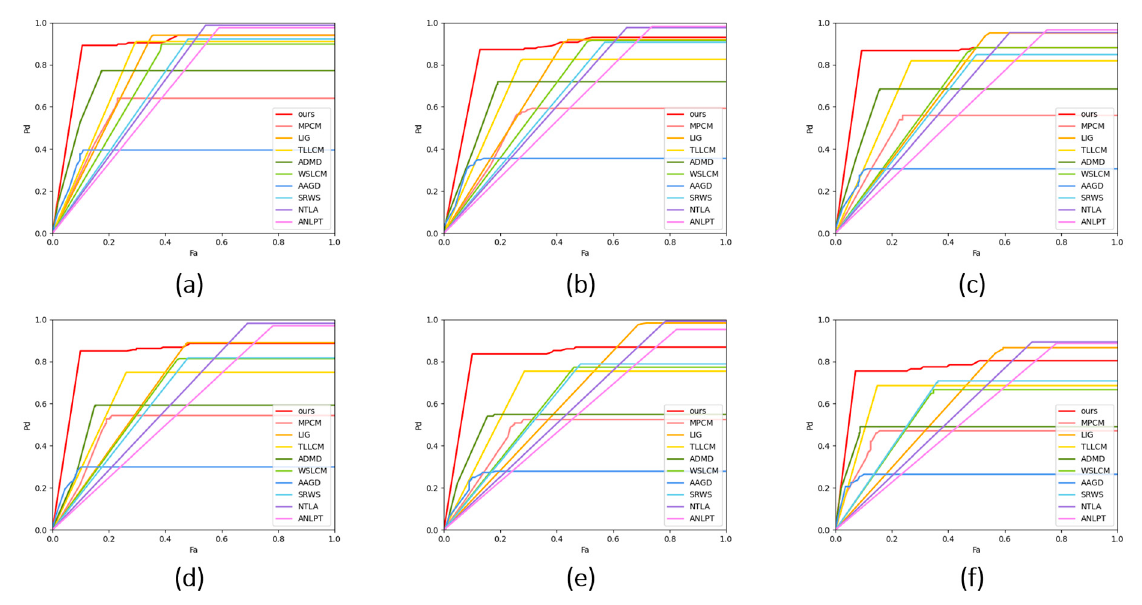
Figure 19. ROC curves of different methods on real datasets. ( a ) is the result of Dataset 1. ( b ) is the result of Dataset 2. ( c ) is the result of Dataset 3. ( d ) is the result of Dataset 4. ( e ) is the result of Dataset 5. ( f ) is the result of Dataset 6. Table 12. AUC of di ff erent methods with real datasets.